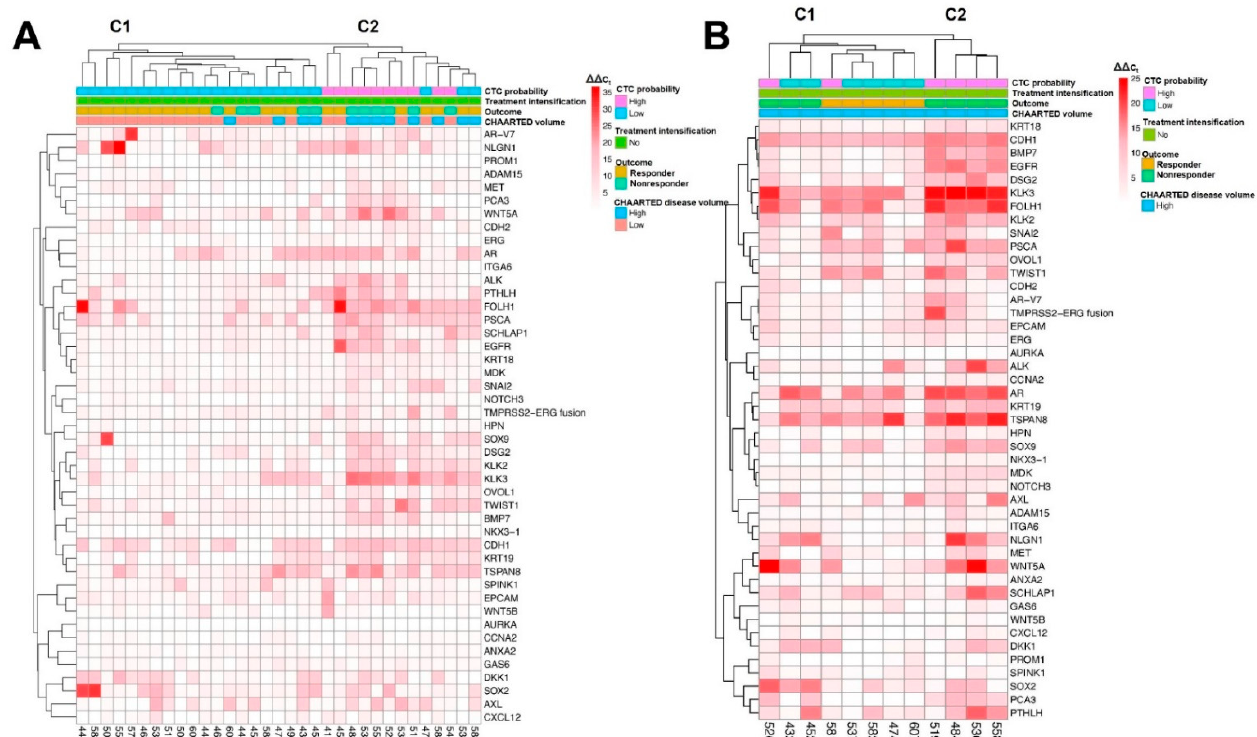
Figure 3. Unsupervised clustering of all patients ( A ) and HV patients ( B ) receiving ADT monother- apy. Patient characteristics, including treatment intensification and CHAARTED volume, and pa- tient outcomes (responder/nonresponder) are annotated above the heatmap, and deidentified pa- tient ID numbers and interrogated genes are annotated on the bottom and right of the heatmap,